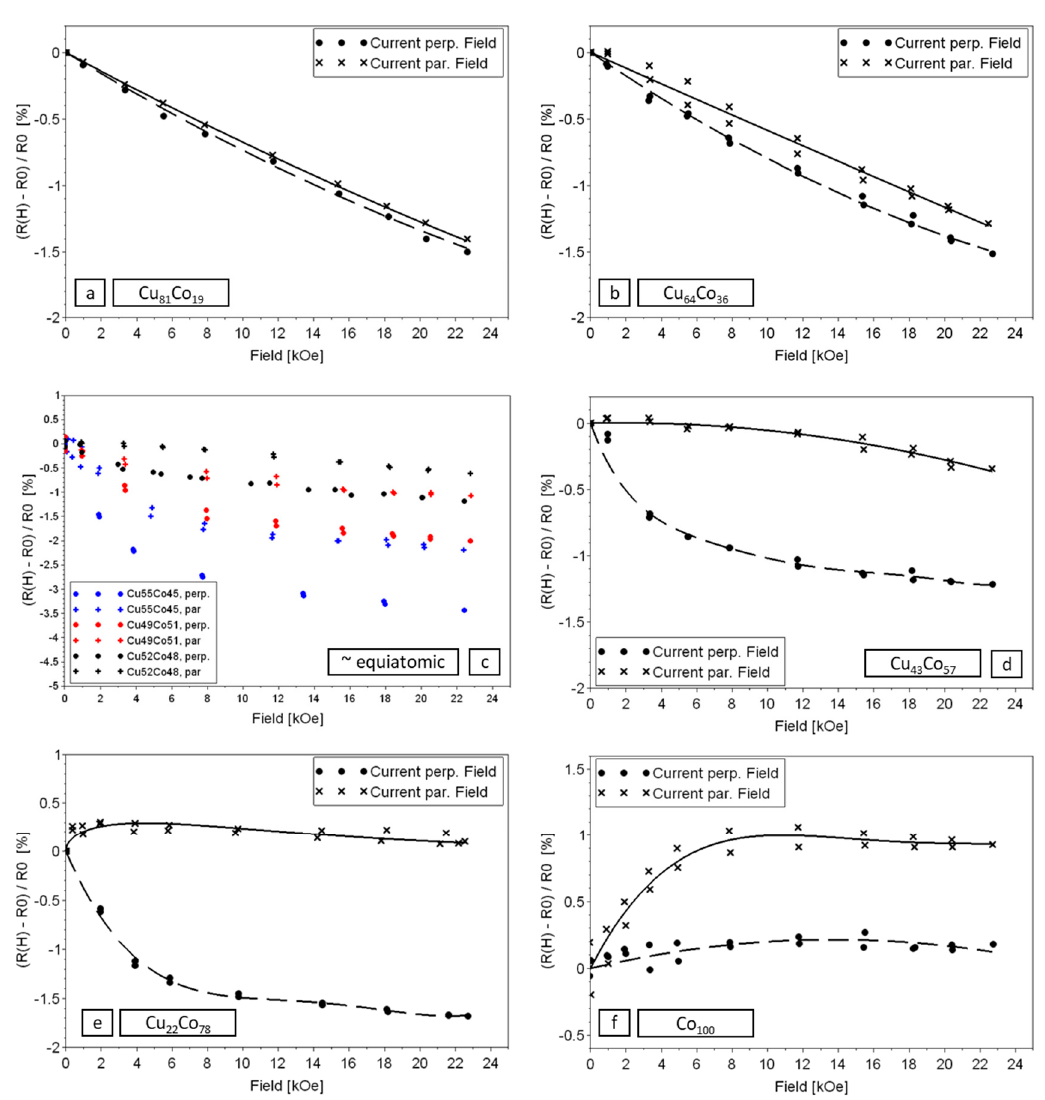
Figure 9. Drop in room-temperature resistance as a function of magnetic fields for Co-based HPT-deformed samples. ( a ) Cu 81 Co 19 . ( b ) Cu 64 Co 36 . ( c ) black: Cu 52 Co 48 deformed at room temperature; red: Cu 49 Co 51 deformed at 200 ◦ C; blue: Cu 55 Co 45 deformed at elevated temperature with the large HPT-tool. ( d ) Cu 43 Co 57 . ( e ) Cu 22 Co 78 , deformed at 300 ◦ C. ( f ) Pure Co. The continuous lines (parallel alignment) and dashed lines (perpendicular alignment) are derived from polynomial fits and serve only as a guide for the eye.